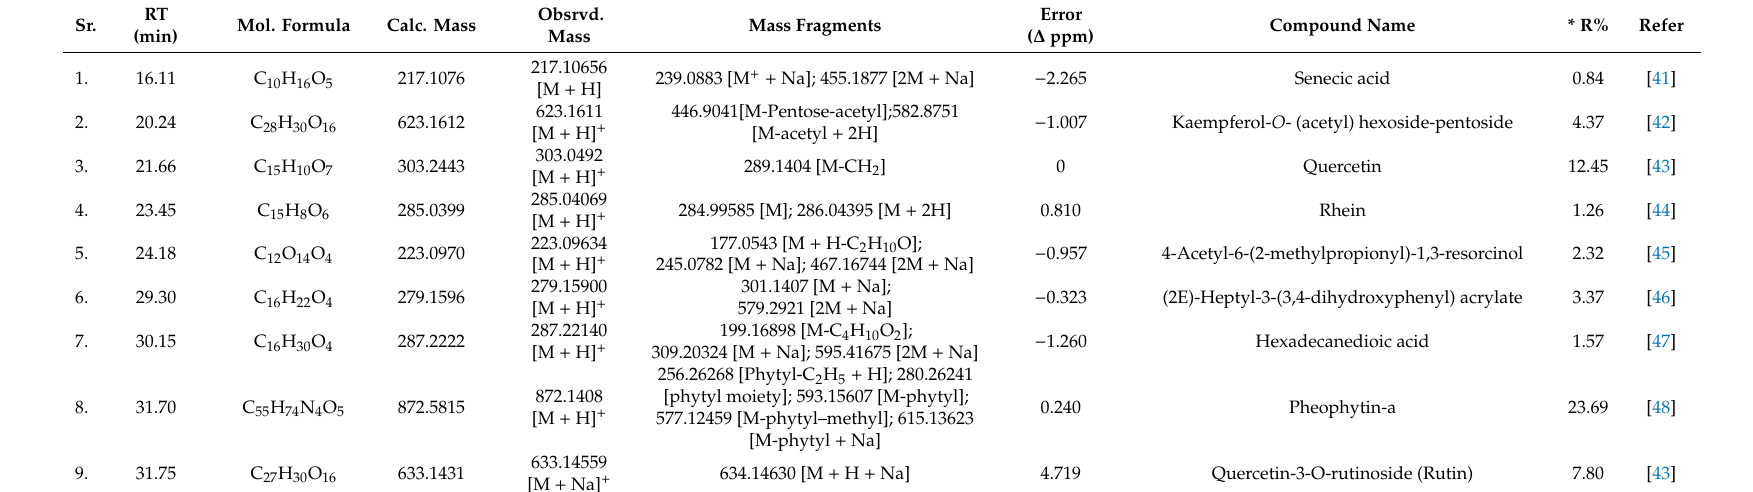
Table 1. Identification of constituents from the aq.-ethanolic extract of Suaeda